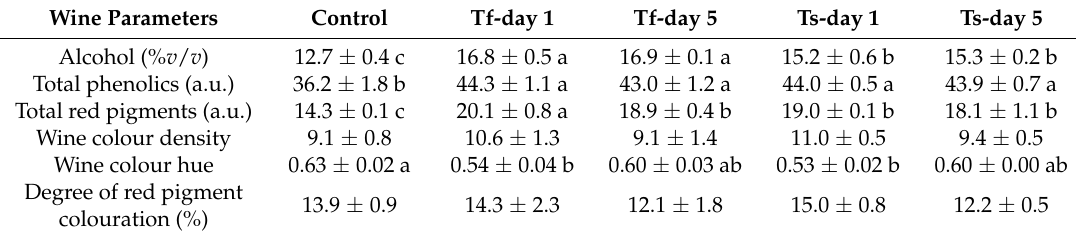
Table 1. Comparison of wine chemical parameters for small-scale fermentation trials 1